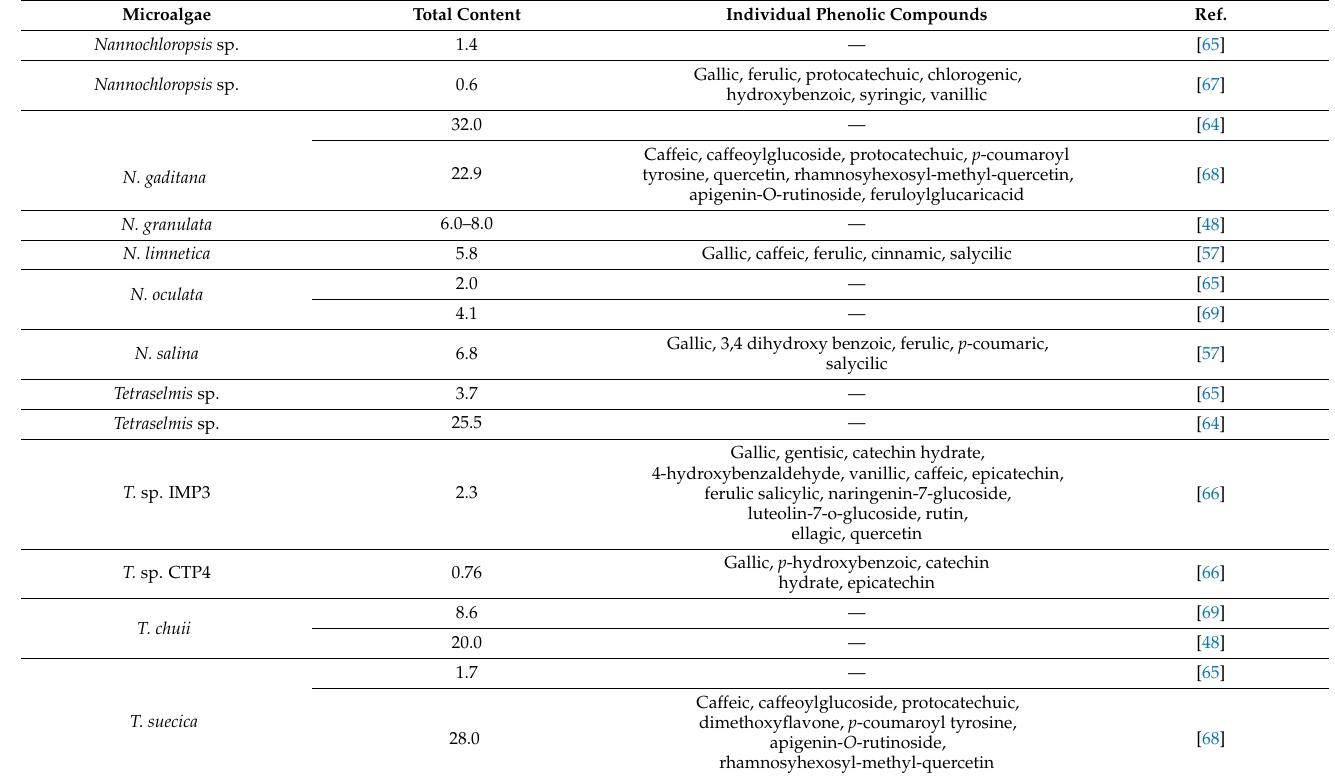
Table 6. Total content (mg of gallic acid equivalent/g of dry weight) and identified phenolic com- pounds in biomass of Nannochloropsis and Tetraselmis